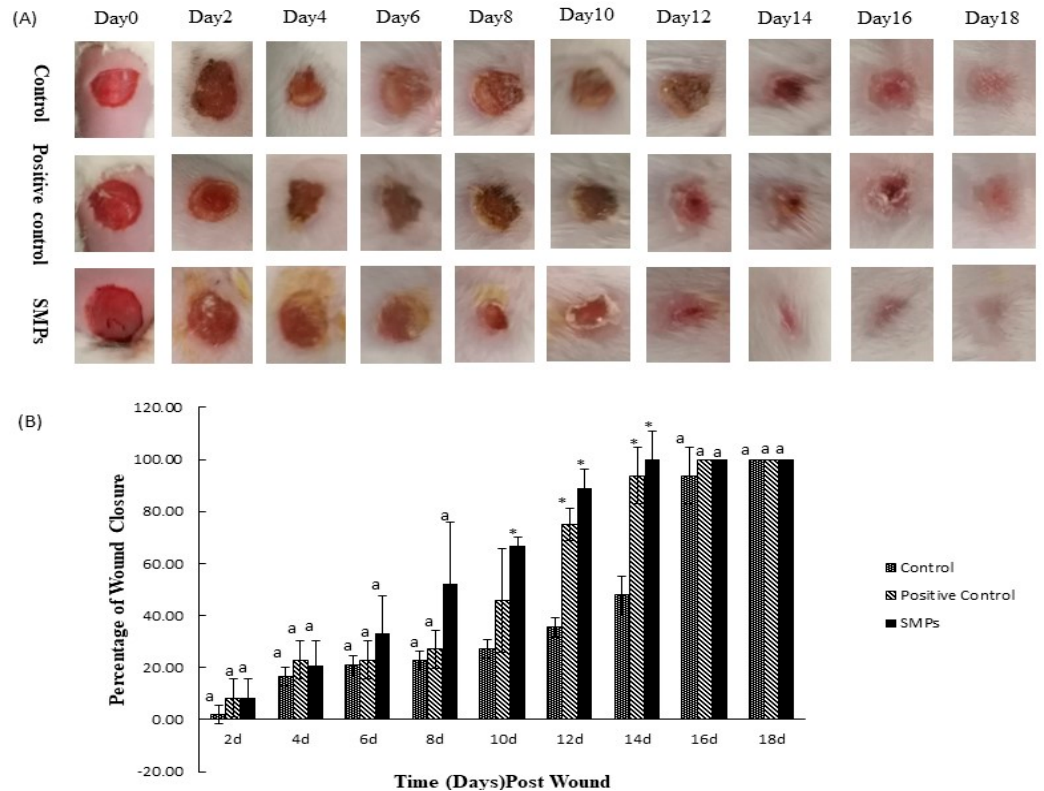
Figure 2. Effect of SMPs on wound healing. ( A ) Representative photos of each group of mice. ( B ) percentage of wound closure (calculated once every two days). Different superscript letters on the same day indicated significant differences between the groups ( p < 0.05) and insignificant different ( p > 0.05), respectively, * indicates a very significant difference ( p < 0.01). Table 4. Effect of SMPs on wound loss and epithelialization (time mean ± S.D., Day).